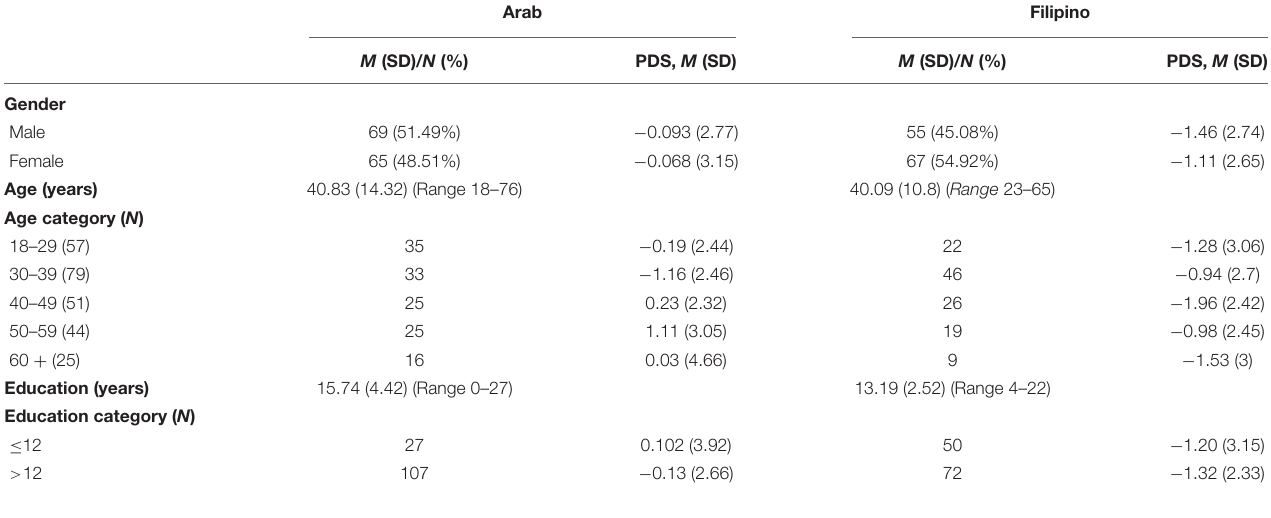
TABLE 1 | Participant demographic variables and percent deviation scores